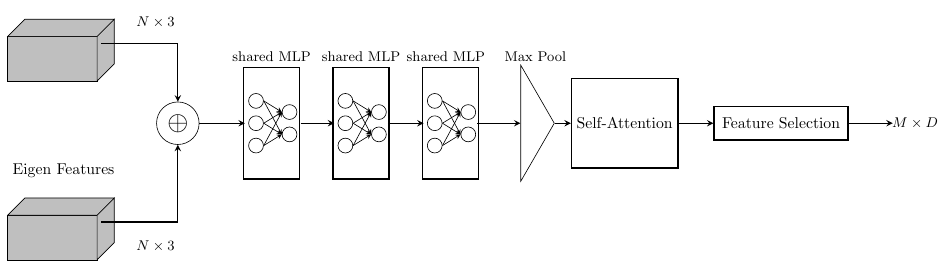
Figure 5. The diagram of the proposed hierarchical sampling algorithm is shown above. The input is our set of points P and the output is the downsampled results Q